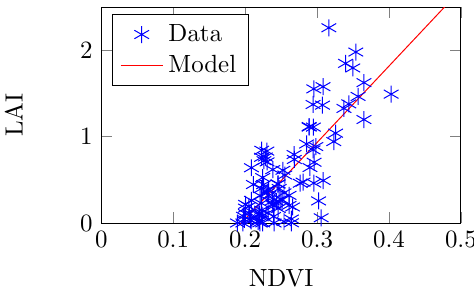
Figure 14. NDVI extracted from a real AVIRIS-C image was used to verify the in situ forest LAI, where R 2 = 0.61, RMSE =